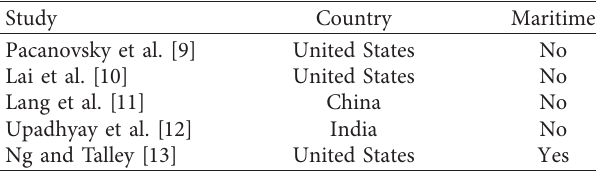
Table 1: Summary of key studies of double-stack rail